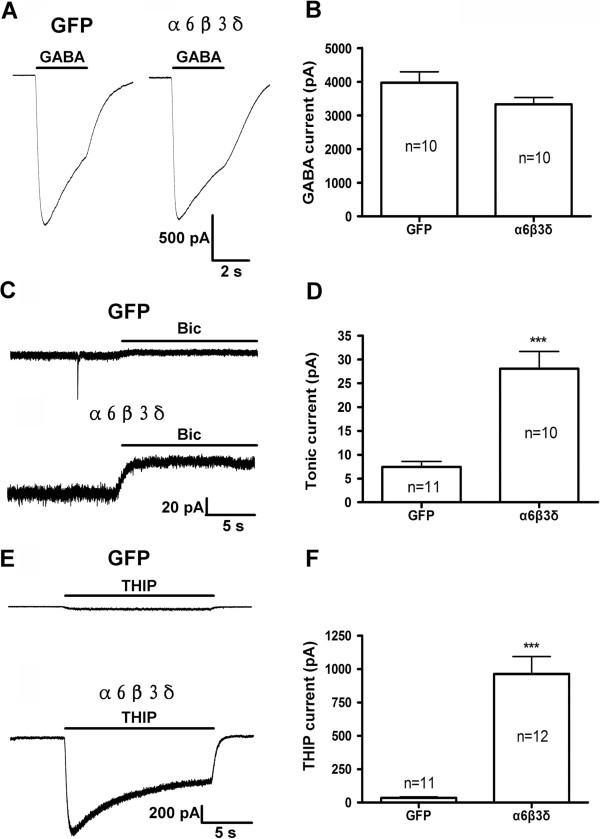
Overexpression of α6β3δ subunits results in large tonic GABA current in cultured hippocampal neurons. A, Typical recordings showing whole-cell currents induced by rapid application of GABA (20 μM) in GFP control and α6β3δ-transfected neurons in the presence of TTX (1 μM) and DNQX (10 μM). B, Summarized data showing no significant difference in whole-cell GABA currents between the two groups. C, Typical traces of tonic GABA currents, revealed by application of Bic (40 μM) in the presence of TTX (1 μM) and DNQX (10 μM), recorded from a GFP control neuron and a α6β3δ-transfected neuron. Holding potential = −70 mV. D, Summarized data showing that the average amplitude of tonic GABA currents was significantly increased in α6β3δ-transfected neurons (28.1 ± 3.6 pA, n = 10), compared to the GFP controls (7.4 ± 1.1 pA, n = 11; ***, p < 0.0001). E, Tonic currents activated by THIP (5 μM) in GFP control and α6β3δ-transfected neurons. F, Summarized data showing a significant increase of THIP-induced tonic currents after transfection of α6β3δ subunits (962 ± 130 pA, n = 12), compared to the GFP controls (35.3 ± 7.4 pA, n = 11; ***, p < 0.0001).